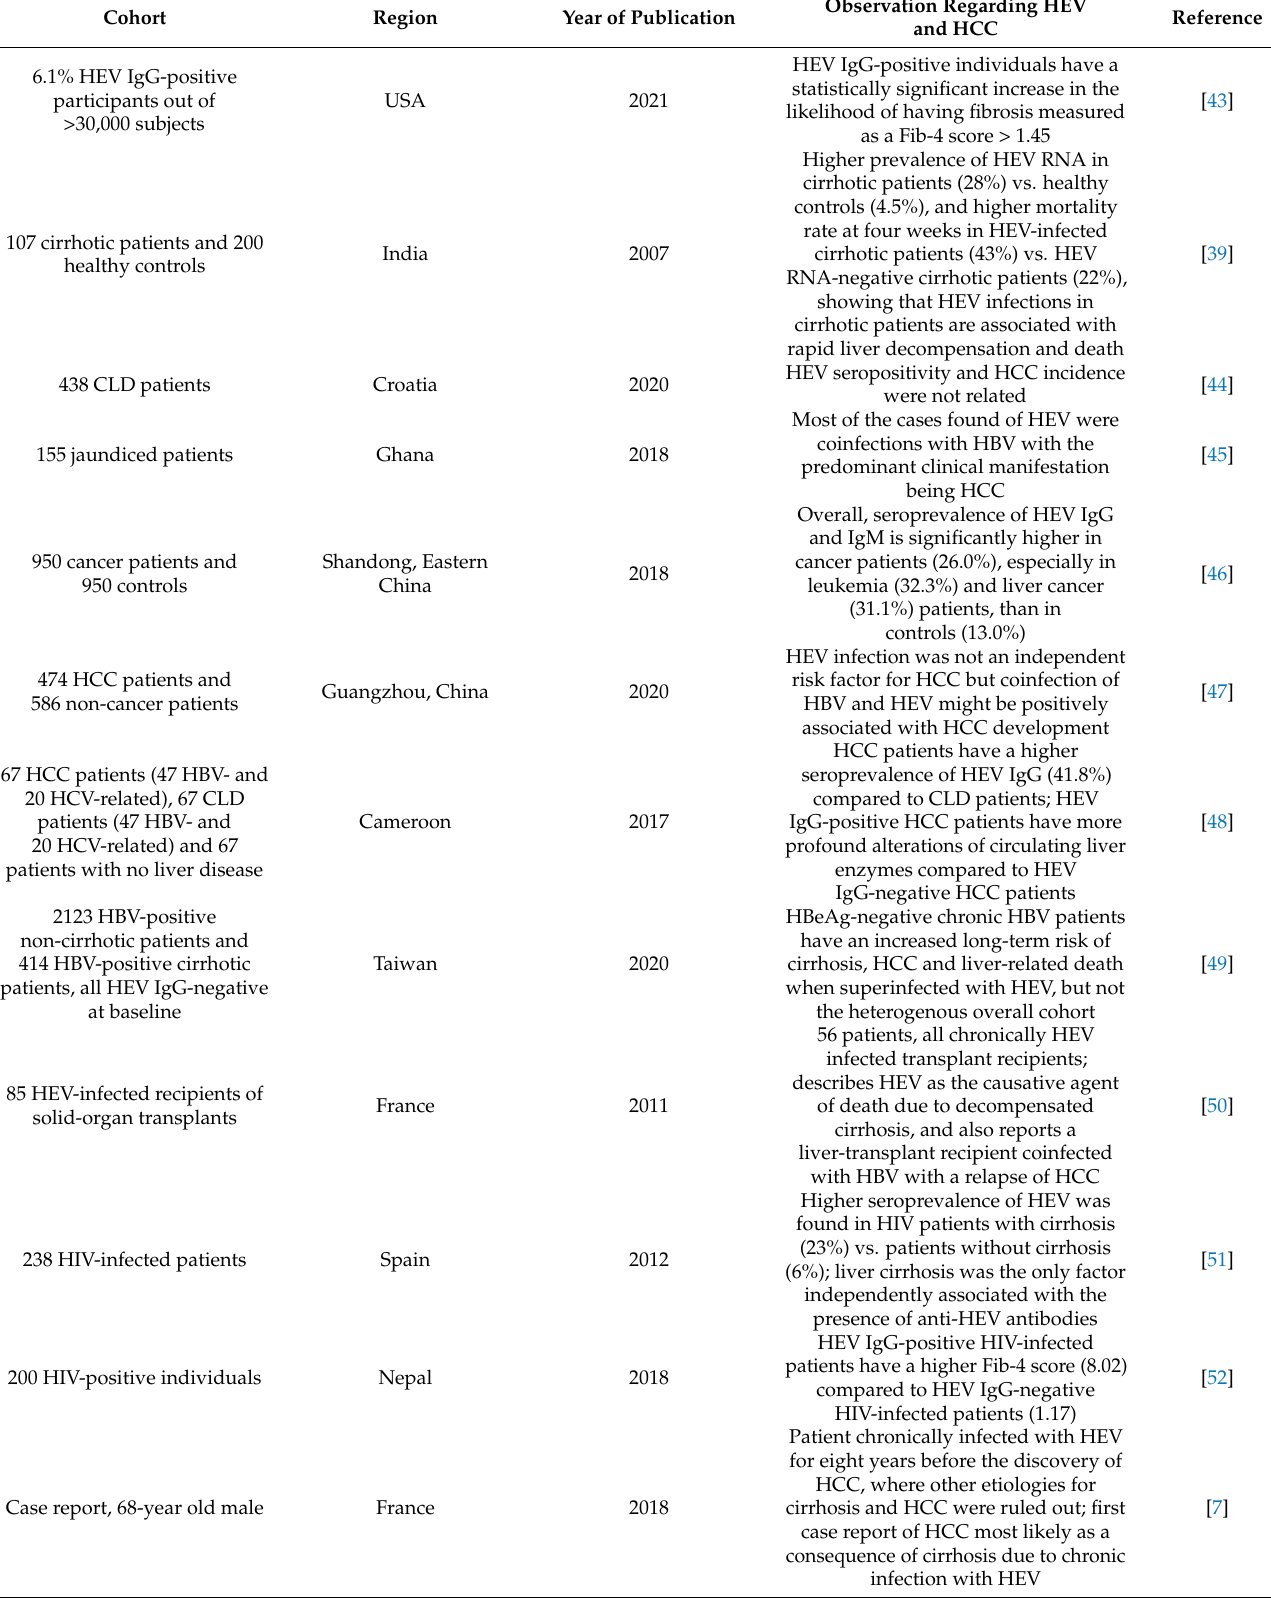
Table 1. Epidemiological studies and case reports on HEV-associated hepatocellular